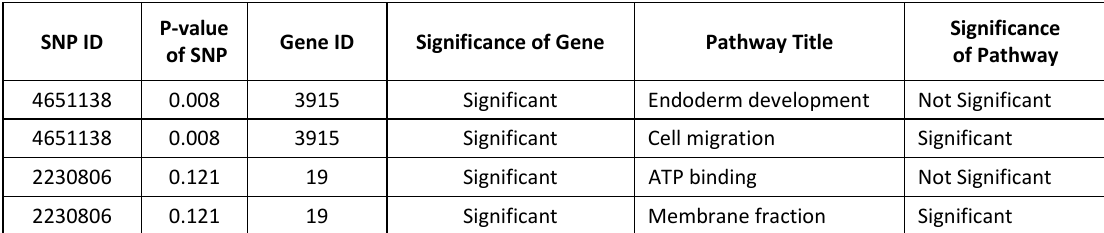
Table 2: Sample SNP-gene-pathway mapping according to AHP based ranking for Alzheimer’s disease.